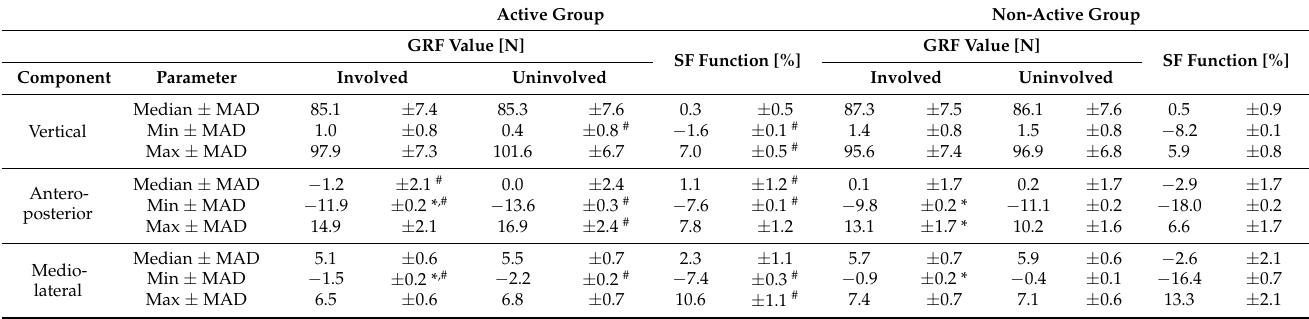
Table 3. GRF results. Median, minimal, and maximal values and ± median absolute deviation ( ± MAD). Active